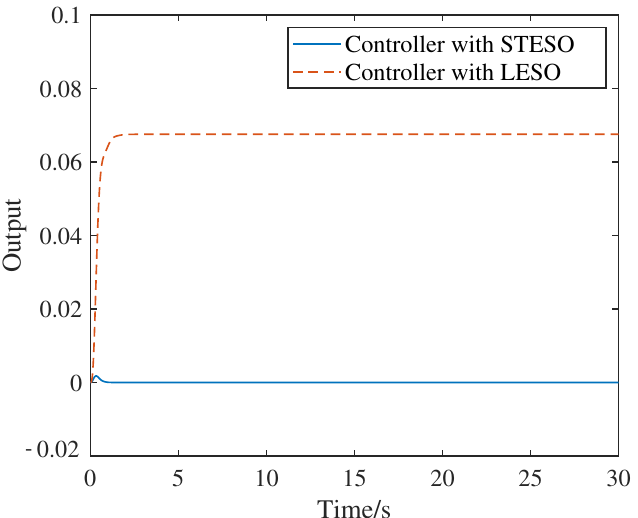
Figure 1. Simulation results of ramp disturbance—system out: controller with STESO (solid line); controller with LESO (dashed